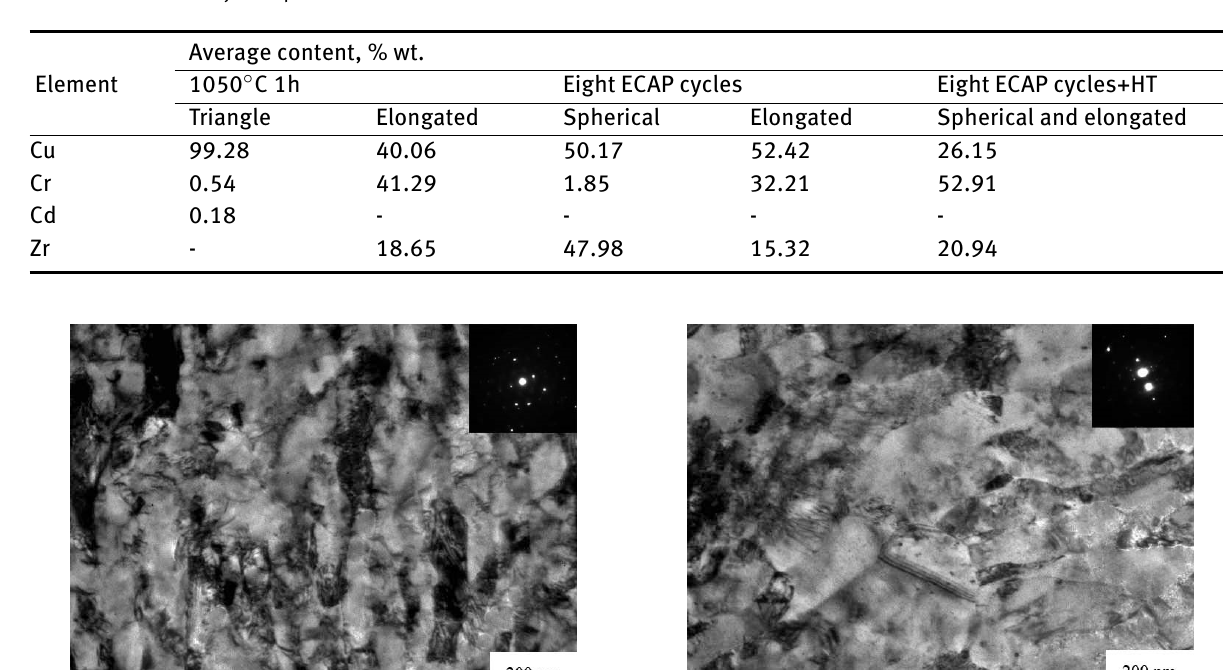
Table 3: Chemical analysis of particles